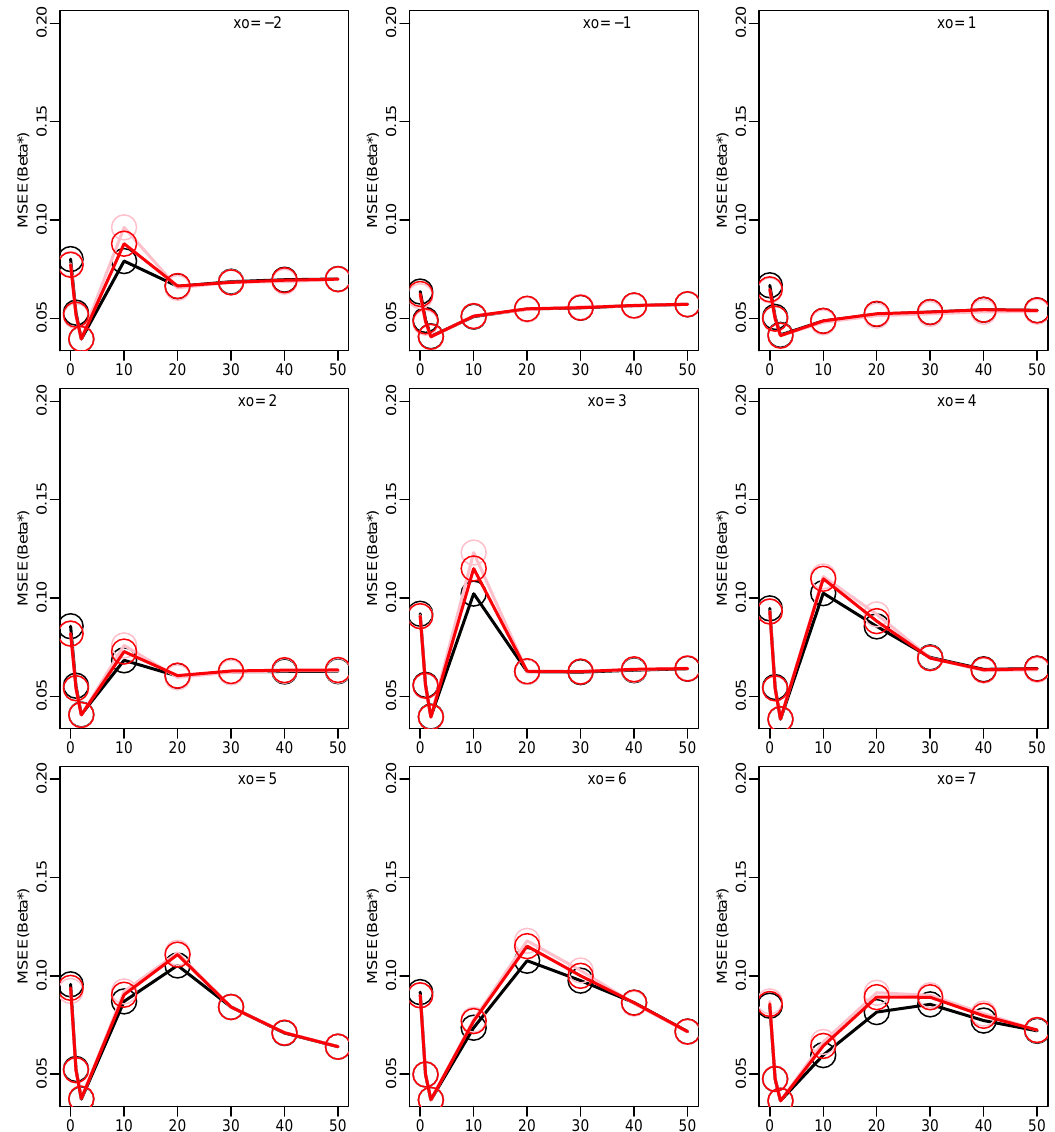
Figure 6. Monte Carlo results for the contaminated multiple regression model. Mean square estimation error MSEE( ˆ β ∗ ) for varying y out and x out . Iterated DCML estimates: MCML++, pink; MCML*+, red; (MCML10 + D,